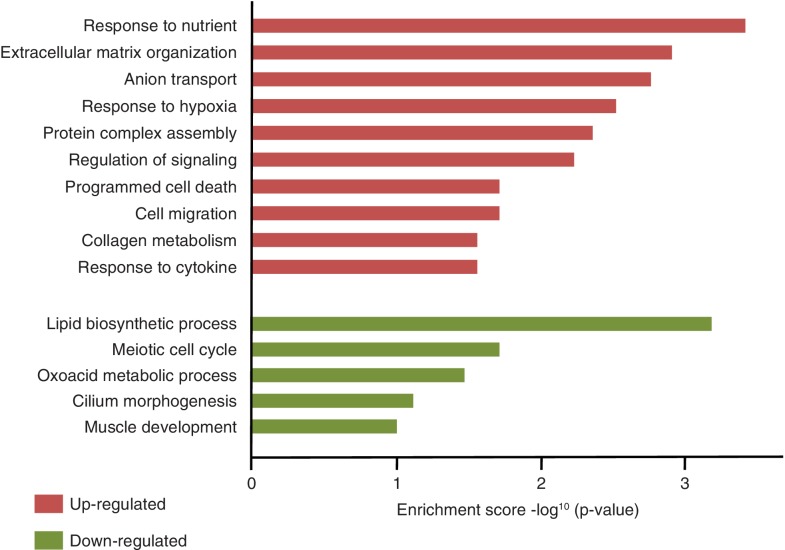
Gene ontology analysis of differentially expressed genes in Fam60a–/– embryos at E9.5.Kyoto Encyclopedia of Genes and Genomes (KEGG) pathways with the top 10 and top five enrichment scores (–log10(ρ-value)) are shown for up-regulated genes (red bars) and down-regulated genes (green bars), respectively. The length of each bar represents the significance of the enrichment.